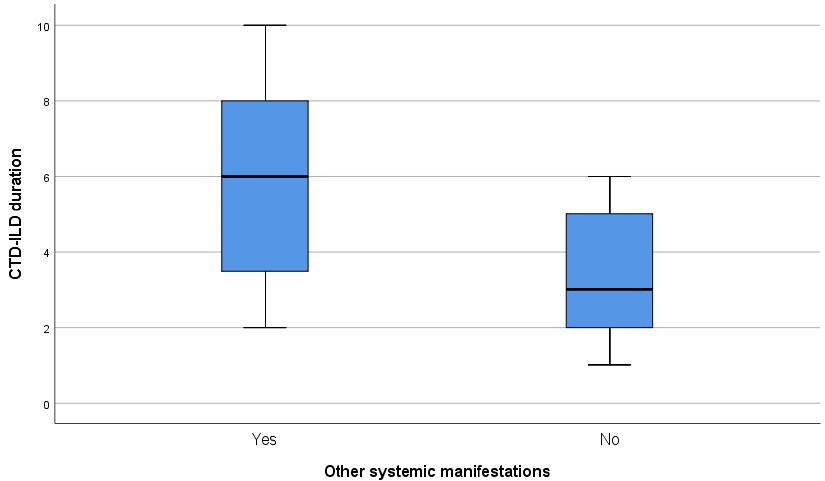
Figure 5. Relationship of CTD-ILD duration and other systemic manifestations.